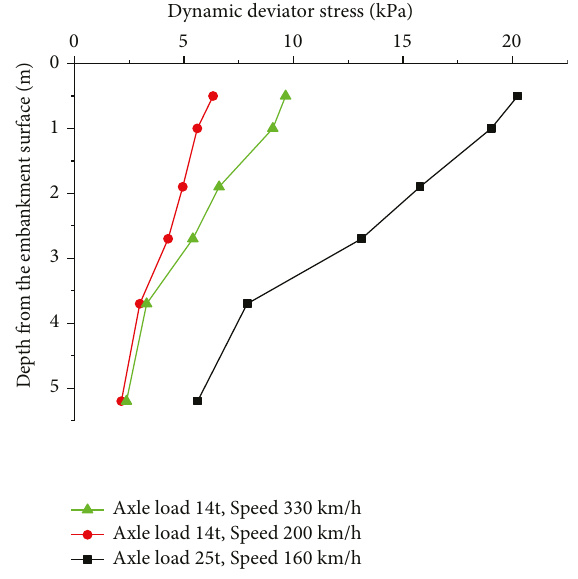
Figure 15: Calculated deviator stress amplitudes under different driving conditions.